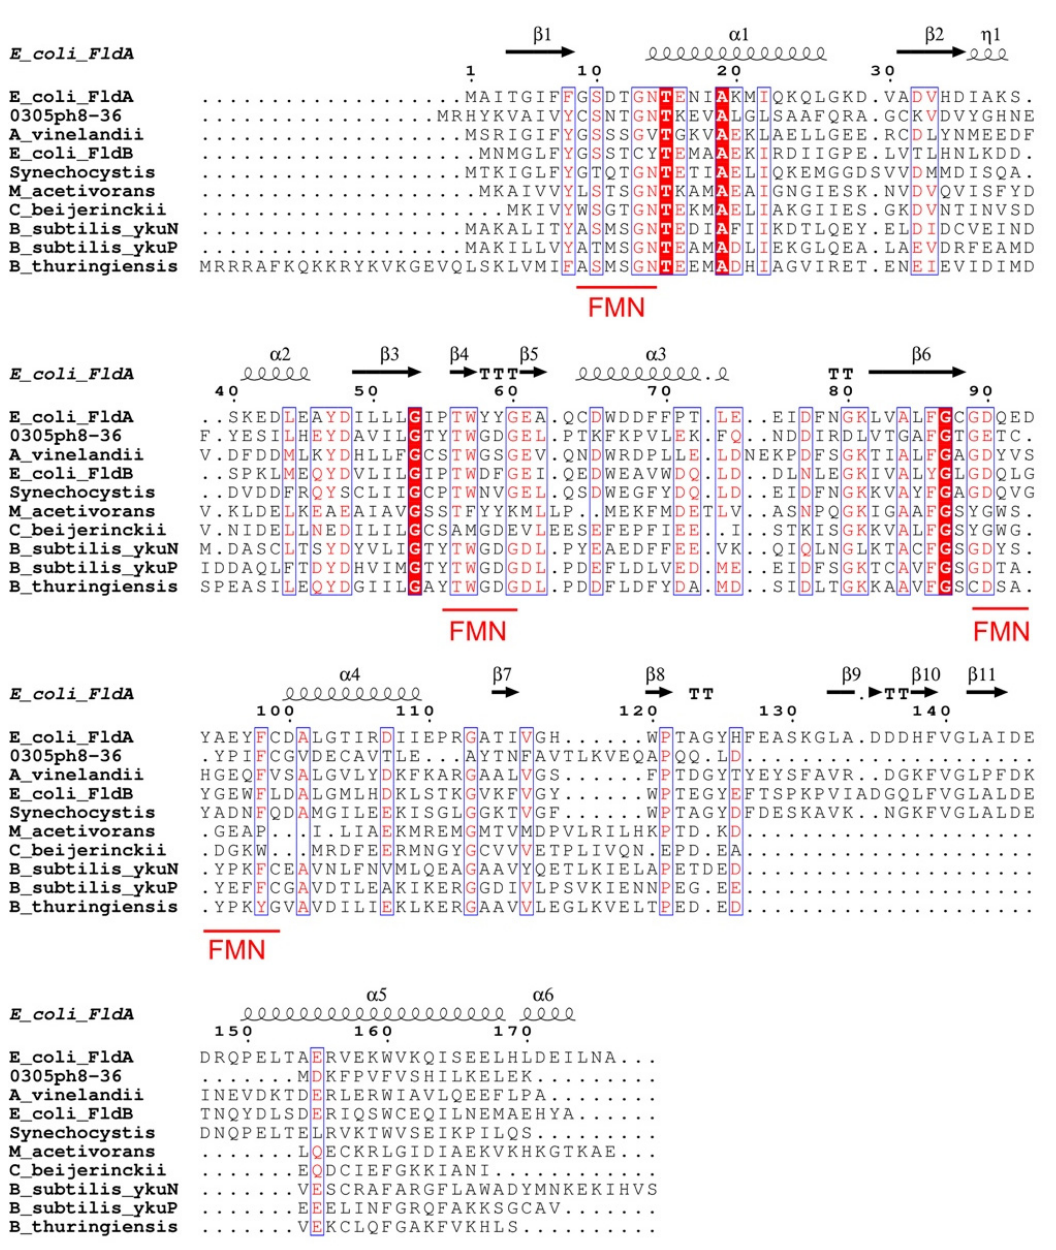
Figure 2. Amino acid sequence alignment of 0305 φ 8-36 phage flavodoxin with selected cellular flavodoxins. Alignment was generated using the Clustal Omega program via the EBI (https://www.ebi.ac.uk/Tools/msa/clustalo/, (accessed on 22 July 2022)). The flavodoxin sequences used were: long chain flavodoxins, E. coli (strain K12) FldA (accession number: P61949), E. coli (strain